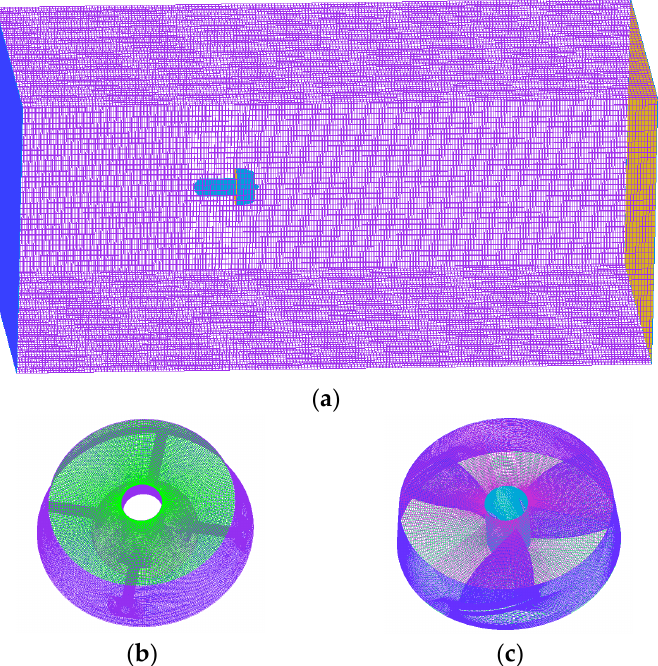
Figure 4. Mesh of the computing domain. ( a ) Viscous entropy generation; ( b ) Mesh of the duct domain; ( c ) Mesh of the impeller domain.